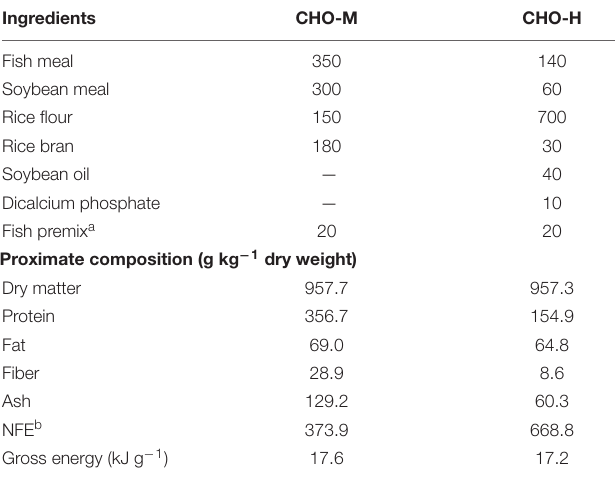
TABLE 1 | Ingredients and chemical compositions (g kg − 1 ) of the challenging